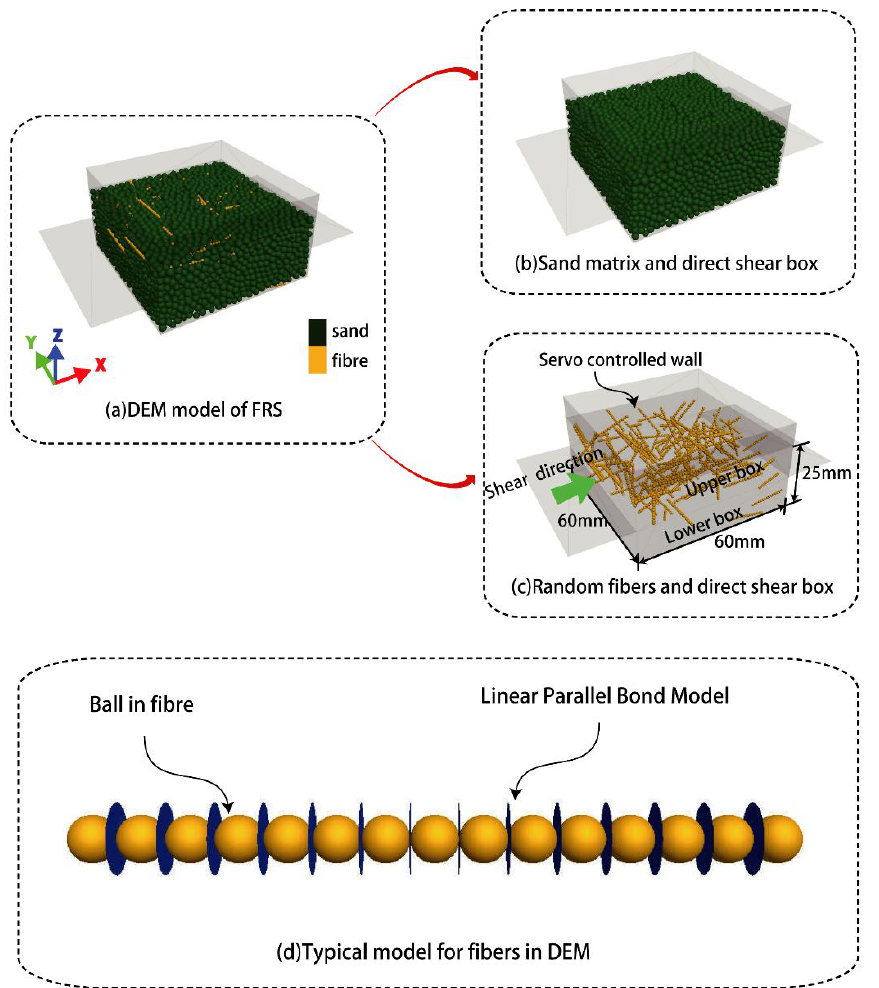
Figure 2. Specimens for three-dimensional DEM simulation: ( a ) DEM model of FRS, ( b ) sand matrix and direct shear box, ( c ) random fibers and direct shear box, and ( d ) typical modelfor fibers in DEM.